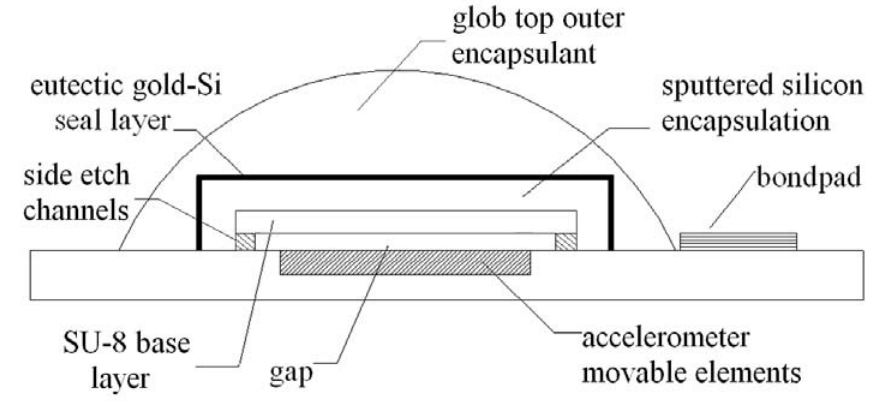
Figure 3. Schematic diagram of encapsulated MEMSTech 50g